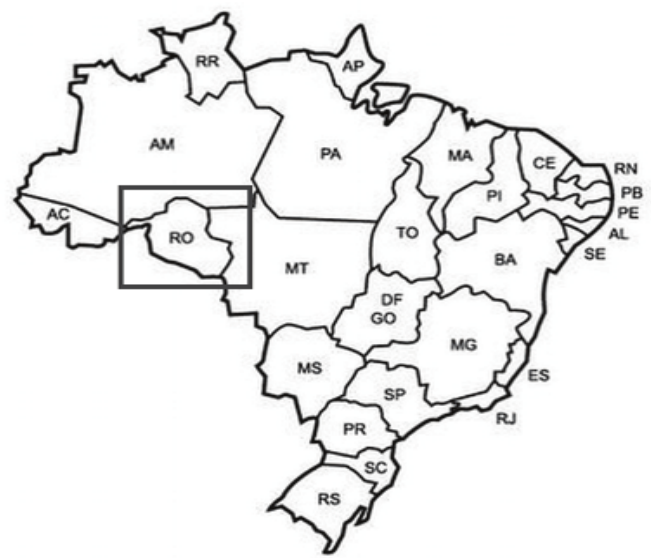
Fig 1 Location of the state Rondônia in Brazil.